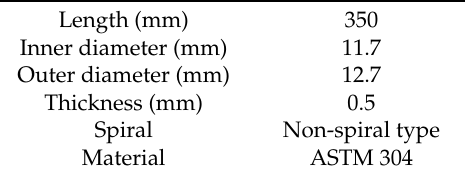
Table 1. Specifications for single-channel exhaust gas recirculation (EGR)